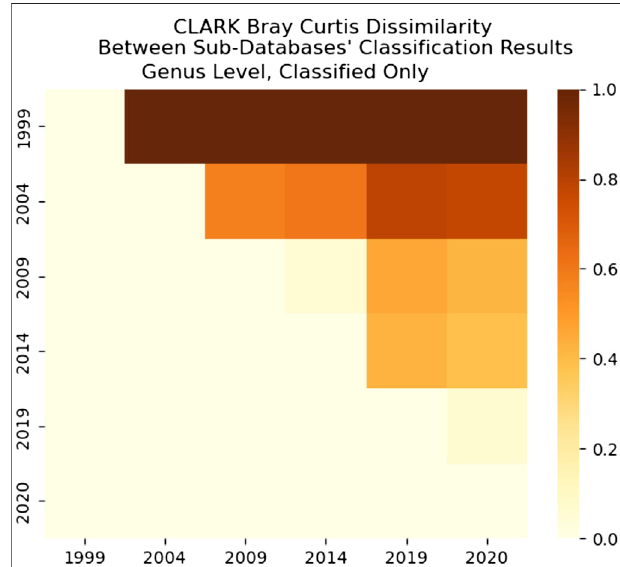
FIGURE 18 | CLARK ’ s Bray-Curtis Dissimilarity score for Genus level. It is a comparison between each sub-databases ’ classi fi cation results. It only includes what CLARK classi fi ed. It is interesting that 1999 results are signi fi cantly different from any other years ’ , while 2009 – 2014 and 2019 – 2020 are the most similar.